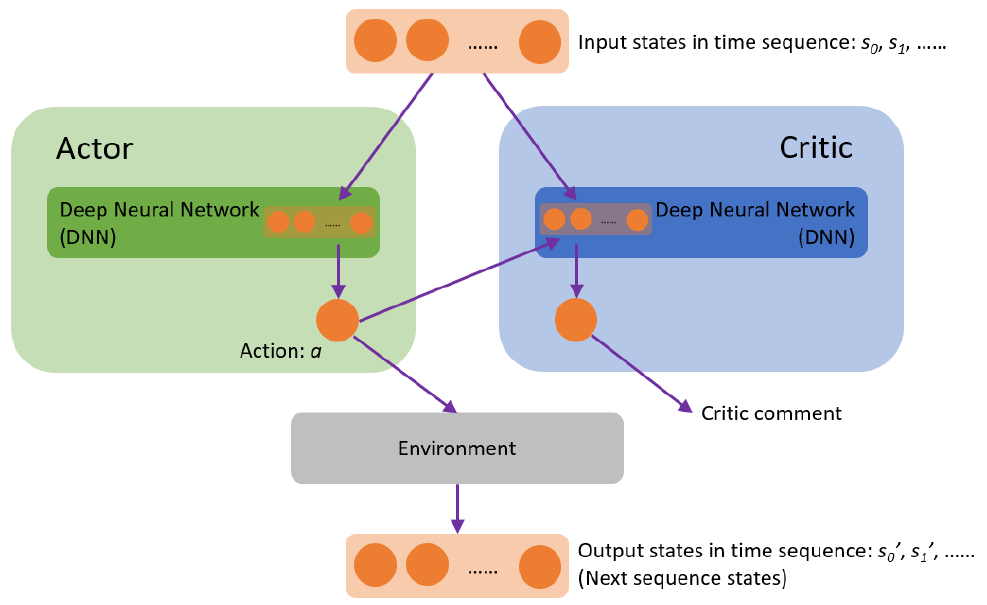
Figure 2. The flowchart of the RDPG.